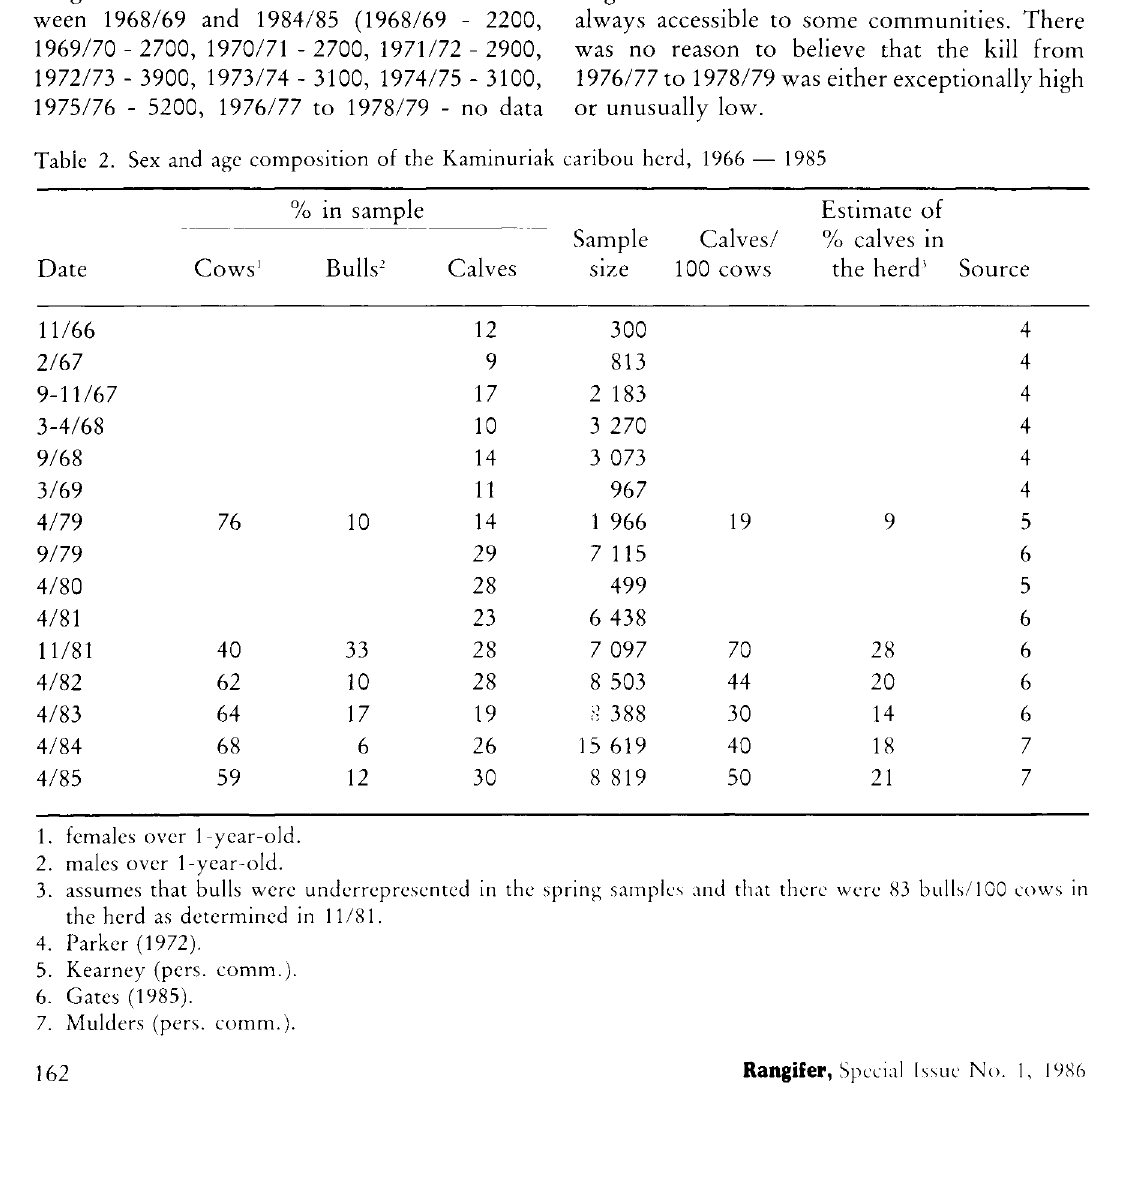
Table 2. Sex and age composition of the Kaminuriak caribou herd, 1966 — 1985 % in sample